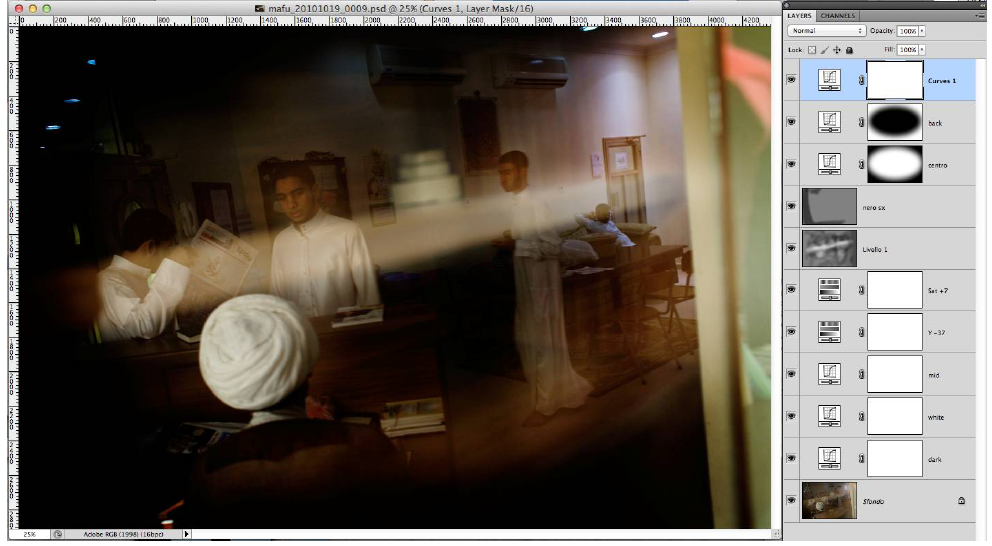
Figure 3. Designed photograph. All materials © Massimiliano